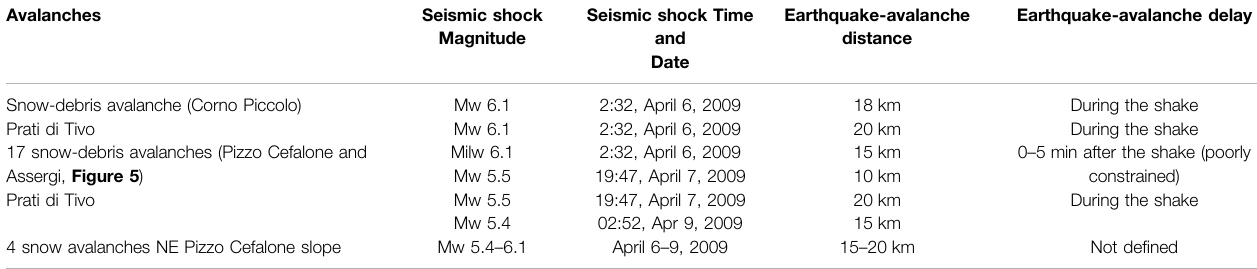
TABLE 4 | Snow and snow-debris avalanches events documented on April 6 – 9, 2009 by orthophotos and eye-witness